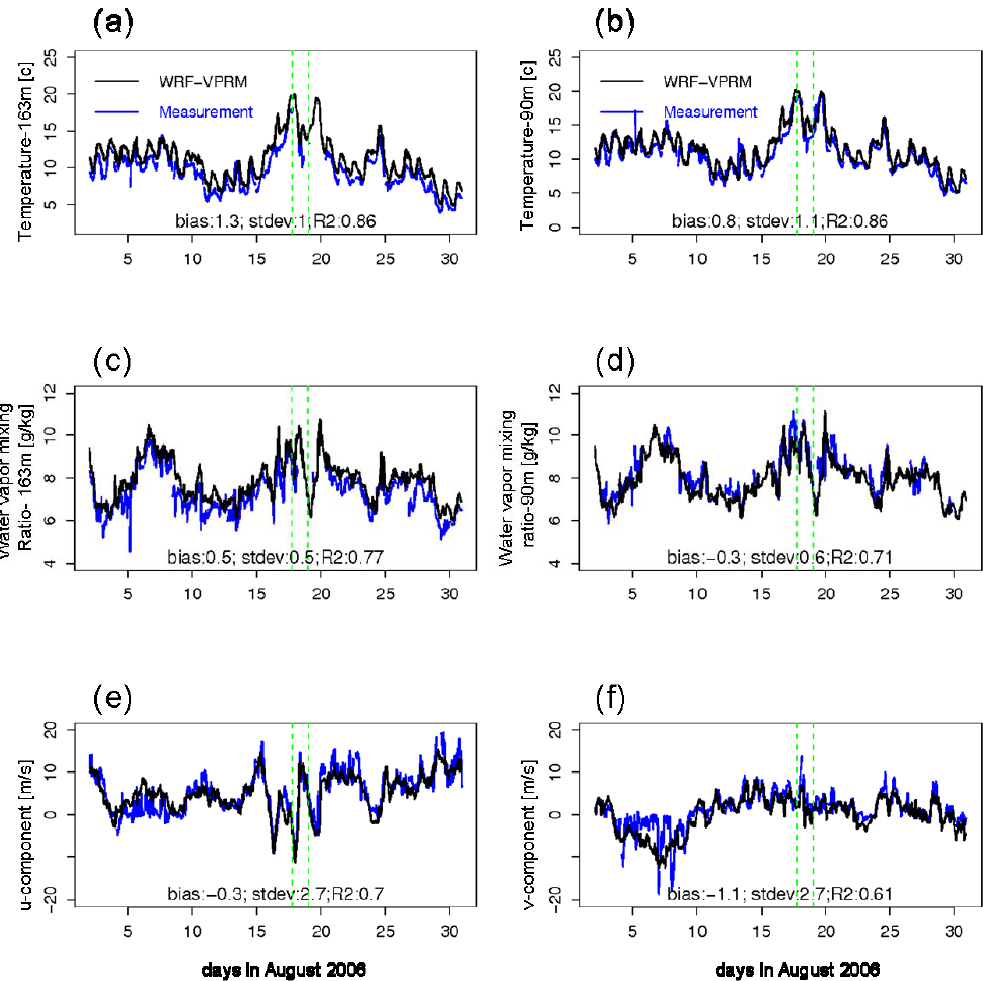
Figure 3. Comparison of measured and modeled meteorological parameters for August Fig. 3. Comparison of measured and modeled meteorological parameters for August 2006 at the OXK site: (a–b) temperature at 163m and 90m, (c–d) water vapor mixing ratio at 163m and 90m and (e-f) horizontal components of wind at 163m. The green dotted vertical lines 2006 at the OXK site: (a-b) temperature at 163 m and 90 m, (c-d) water vapor mixing denotes the passage of a cold front investigated in detail (see Sect. ratio at 163 m and 90 m and (e-f) horizontal components of wind at 163 m. The green dotted vertical lines denotes the passage of a cold front investigated in detail (see Sect. 4.1)